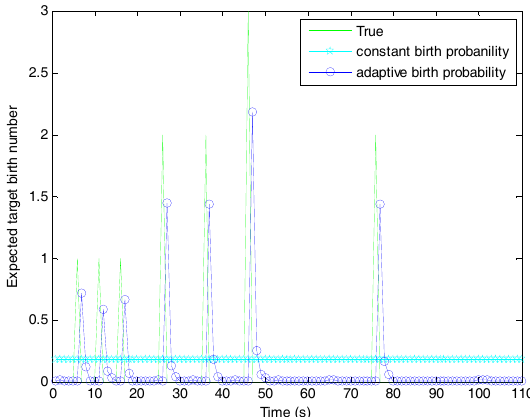
Figure 8. Expected number of newborn targets in constant and adaptive target birth probabilities.